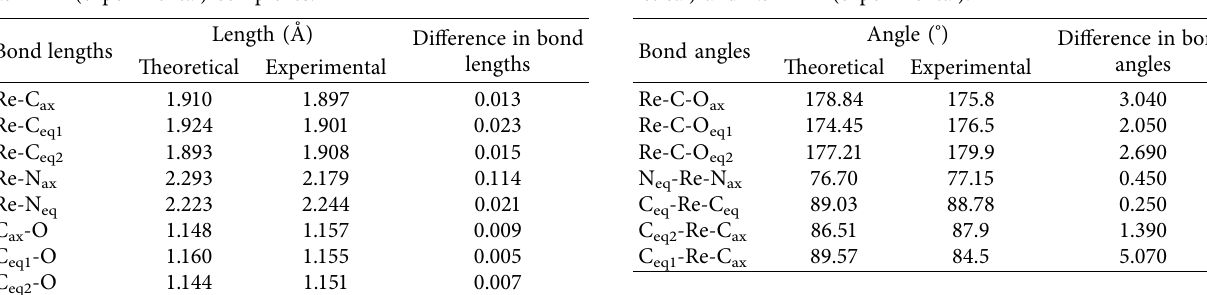
Table 1: Lengths of some bonds of the ReABT (theoretical) and ReAPBT (experimental) complexes.